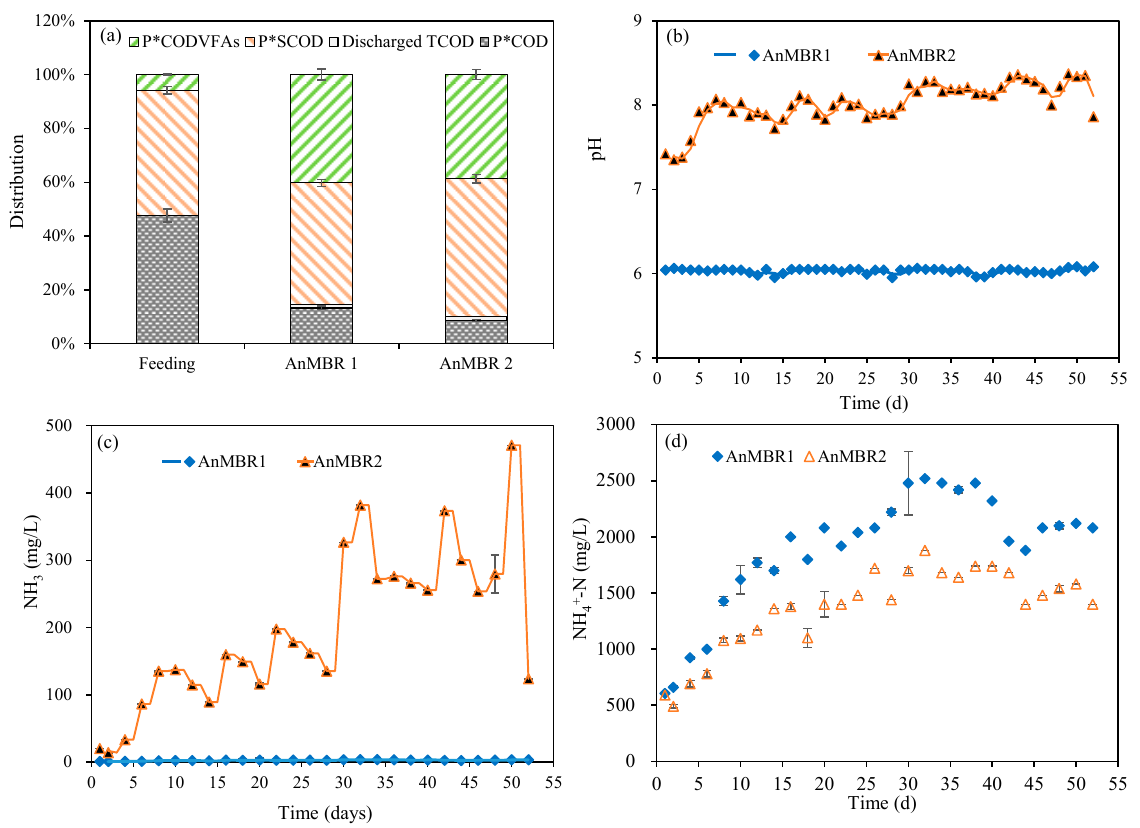
Figure 3. ( a ) Mass balance based on COD during the VFA production and changes of ( b ) pH, ( c ) NH 4+ -N, and ( d ) NH 3 at OLR 2 g-VS/(L·d). During the anaerobic digestion of CM, VFA, especially acetic acid and propionic acid, can be formed during the degradation of proteins and amino acids [15,39]. The total Kjeldahl nitrogen content of as-received CM was 26.3% (Table 1), which was much higher than that of other manure such as cow manure (2.9%) [16]. It can be assumed that the composition of VFA was affected by the digestion of nitrogen-containing compounds in CM. The released NH 4+ -N in the AnMBR is mainly due to the hydrolysis of proteins and amino acids. At OLR 2 g-VS/(L · d), the average concentrations of ammonia nitrogen in AnMBR1 and AnMBR2 were 2262 and 1645 mg/L, respectively (Table 3). As the pH in AnMBR2 showed a gradual increasing trend with the extension of the reactor operating time, from 7.9 at the initial feeding stage to 8.3 (Figure 3b), the corresponding free ammonia nitrogen gradually increased, from initial 86 to about 471 mg/L (Figure 3c,d). As for AnMBR1, with a constant pH control throughout the fermentation, the content of free ammonia was kept close to zero. The increase in NH 3 -N in AnMBR2 is the main reason why the NH 4+ -N in AnMBR2 was lower than AnMBR1 (Figure 3d). It has been reported in other literature that, although, ammonia nitrogen can be used as an essential nutrient for microbial growth, it may inhibit microbial activity (mainly methanogens) at high concentrations [4,40]. It has been reported that as the concentration of total ammonia nitrogen (free ammonia and ammonium) reaches levels higher than 1.7 g/L, it inhibits methanogenesis [3,4]. This can be taken as a natural method for methane production inhibition and VFA